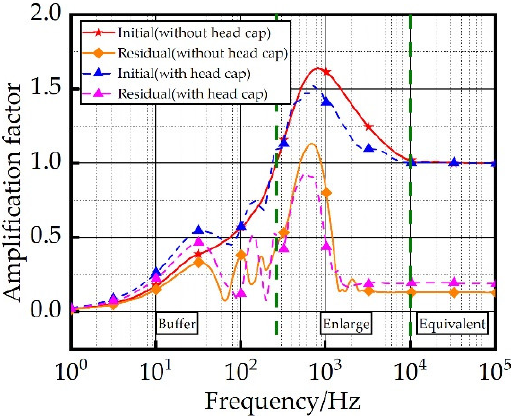
Figure 20. Acceleration shock response spectrum of vehicle vertical water entry at 100 m/s.